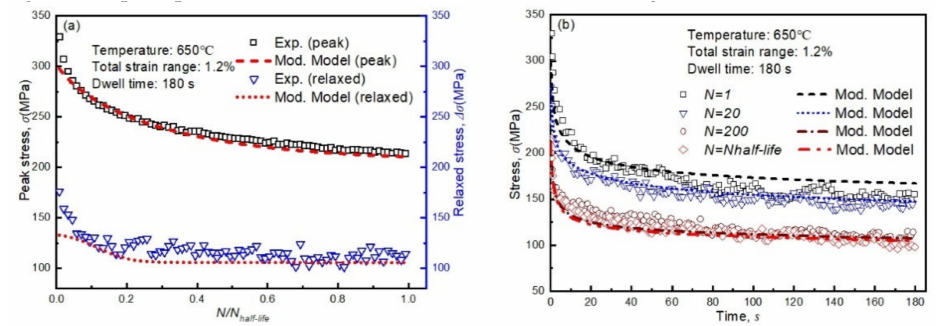
Figure 16. Comparison of simulated and experimental responses at 1.2% total strain range with 180 s peak tensile strain dwell at 650 ◦ C, ( a ) evolution of peak stress and relaxed stress; ( b ) stress evolution during dwell time at various